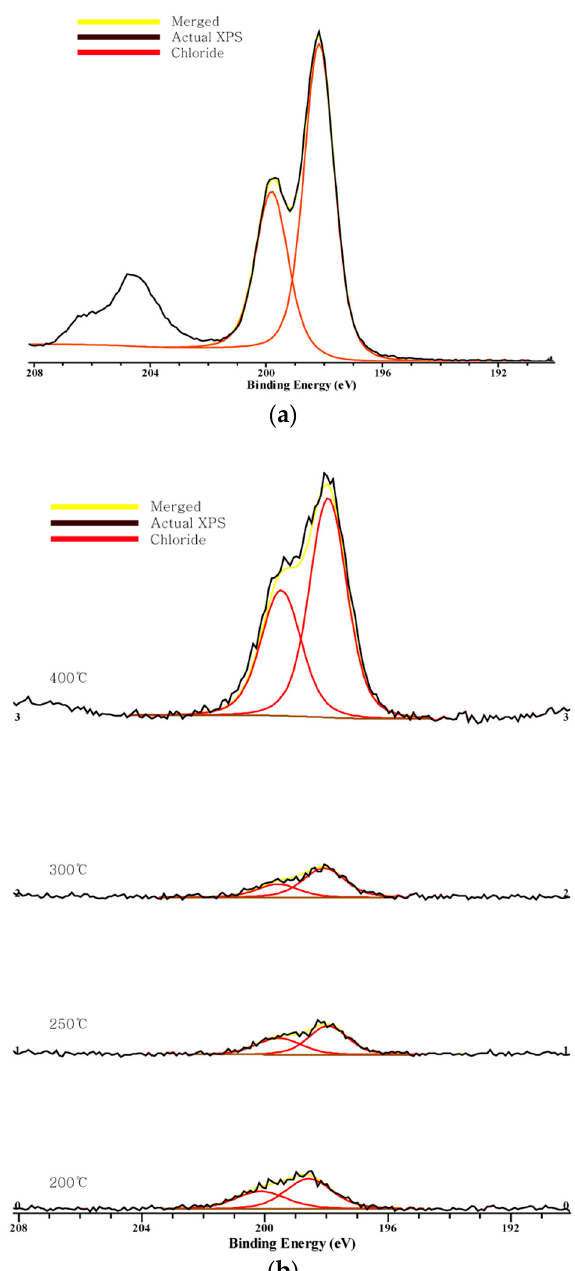
Figure 4. Chlorine 2p XPS spectra: ( a ) NaCl; ( b ) combined.